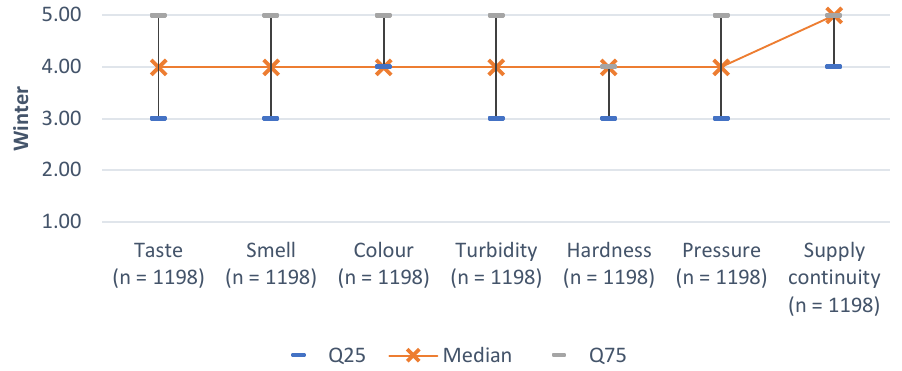
Figure 5. Respondents’ evaluation of individual tap water parameters during the winter period.